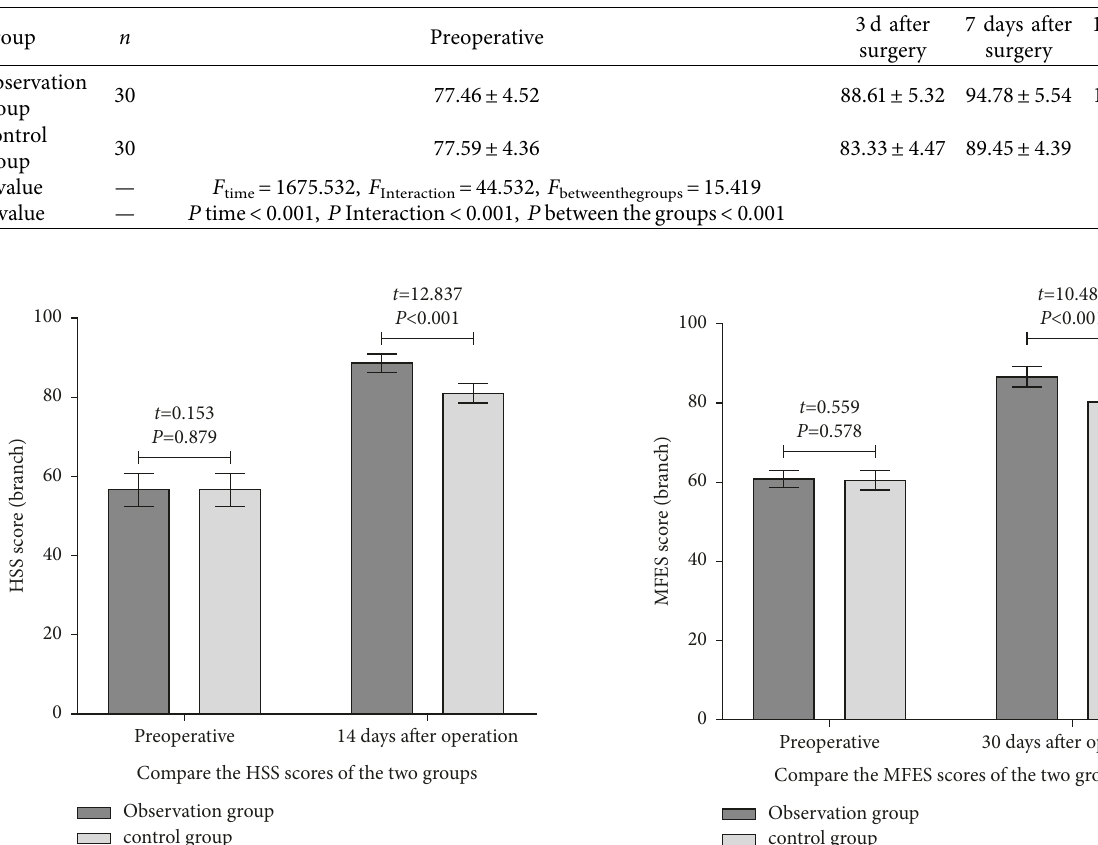
Table 1: Comparison of knee flexion degrees between the two groups at different time periods.